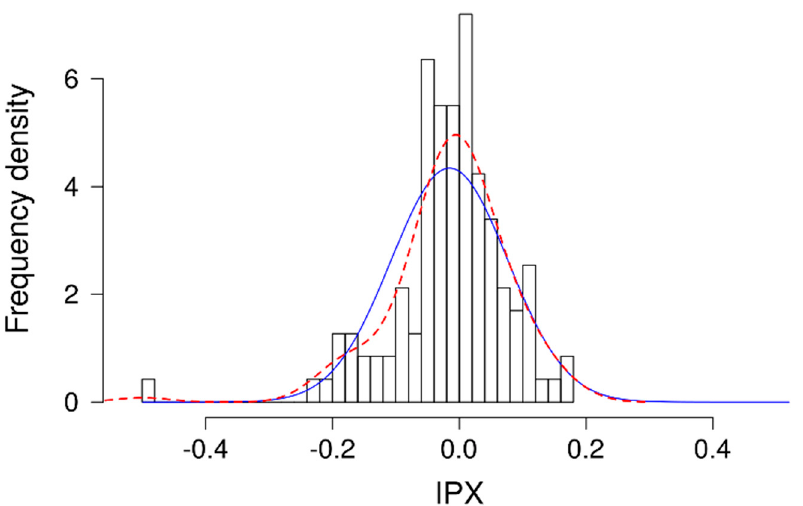
Figure 6. Distribution of IPX values for vehicle solution-treated cells. Density histogram for the intracellular proton index (IPX) of 118 technical replicates (control lanes). Data from 38 separate measurements. Mean of − 0.015, SD of 0.092. The density curve for the data (red) is presented along a normal distribution curve with the above-mentioned parameters (blue). Based on these data, a 95% confidence interval was calculated, which ranged from − 0.2 to 0.17. Plates in which more than one control lane presented an IPX average beyond the above-mentioned range were excluded from analysis. Similarly, plates in which more than 1 histamine control failed to induce an increase in proton secretion were also excluded.